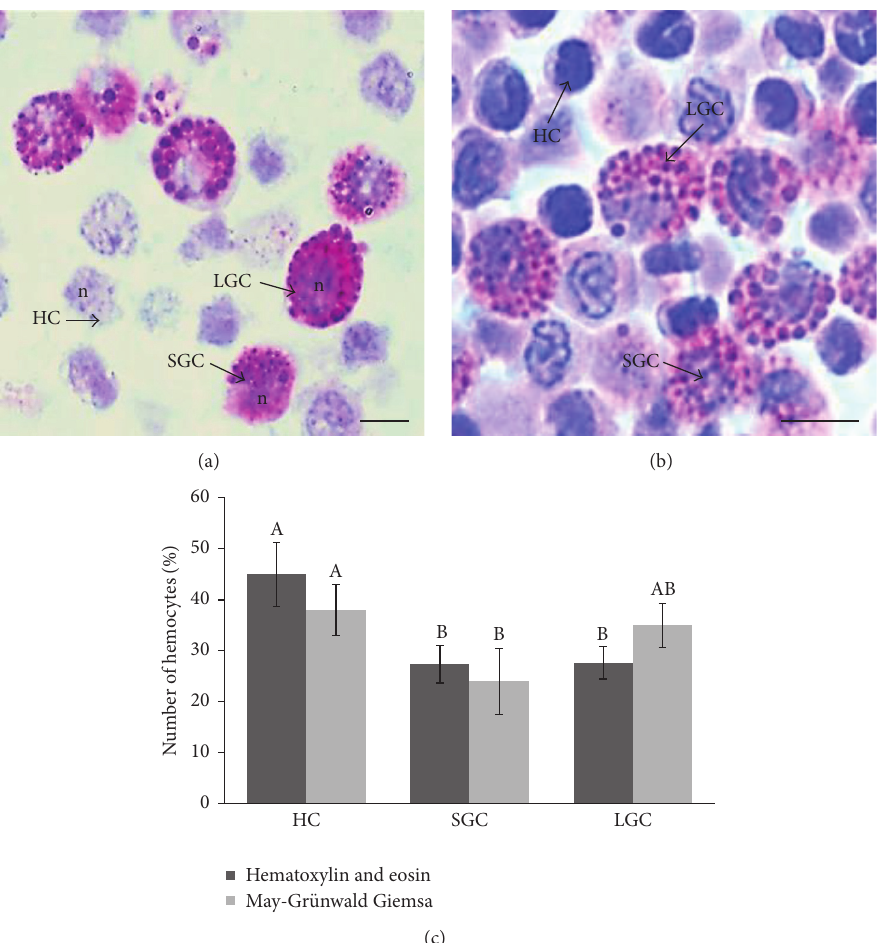
Figure 1: Hemocytes of Litopenaeus vannamei . (a) Micrographs of hemocytes stained with hematoxylin-eosin in resin histological sections and (b) hemocytes stained with May-Gr¨unwald Giemsa, showing three types of hemocytes: small-granule cells (SGC), large-granule cells (LGC), and hyaline cells (HC). Scale bar = 5 𝜇 m. (c) Differential hemocyte count (DHC) in histological resin sections stained with hematoxylin-eosin and May-Gr¨unwald Giemsa. The relative percentage of DHC was calculated by observing digital images analyzing at least 500 hemocytes. Data represent mean ± SD. Letters indicate significant differences ( 𝑃 < 0.05 ) between hemocyte types. n =